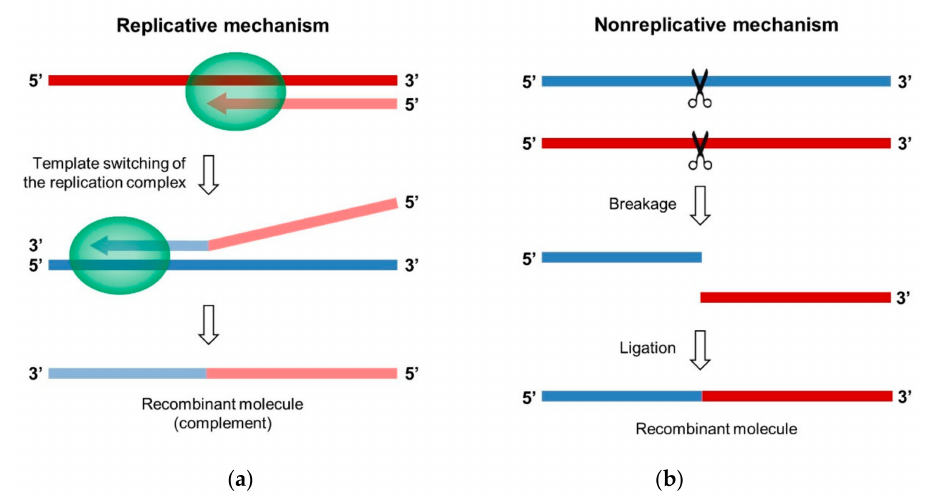
Figure 4. Mechanisms of replicative and nonreplicative RNA recombination. ( a ) The replicative mechanism of copy-choice. The replication complex pauses during the synthesis of the complementary strand of the RNA donor (in red) and dissociates from the RNA donor template. Then, the incomplete nascent RNA strand interacts with the acceptor RNA (in blue) where the replication complex reassembles and the synthesis of the complementary strand resumes. The complementary strand is indicated by lighter colors. ( b ) The nonreplicative mechanism of breakage-ligation. The two parental RNA molecules are degraded, and then the two fragments generated are covalently